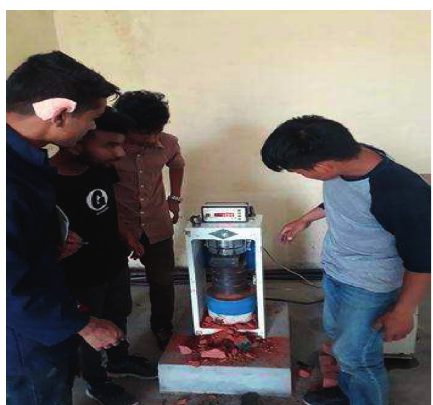
Figure 9: Compressive strength test.